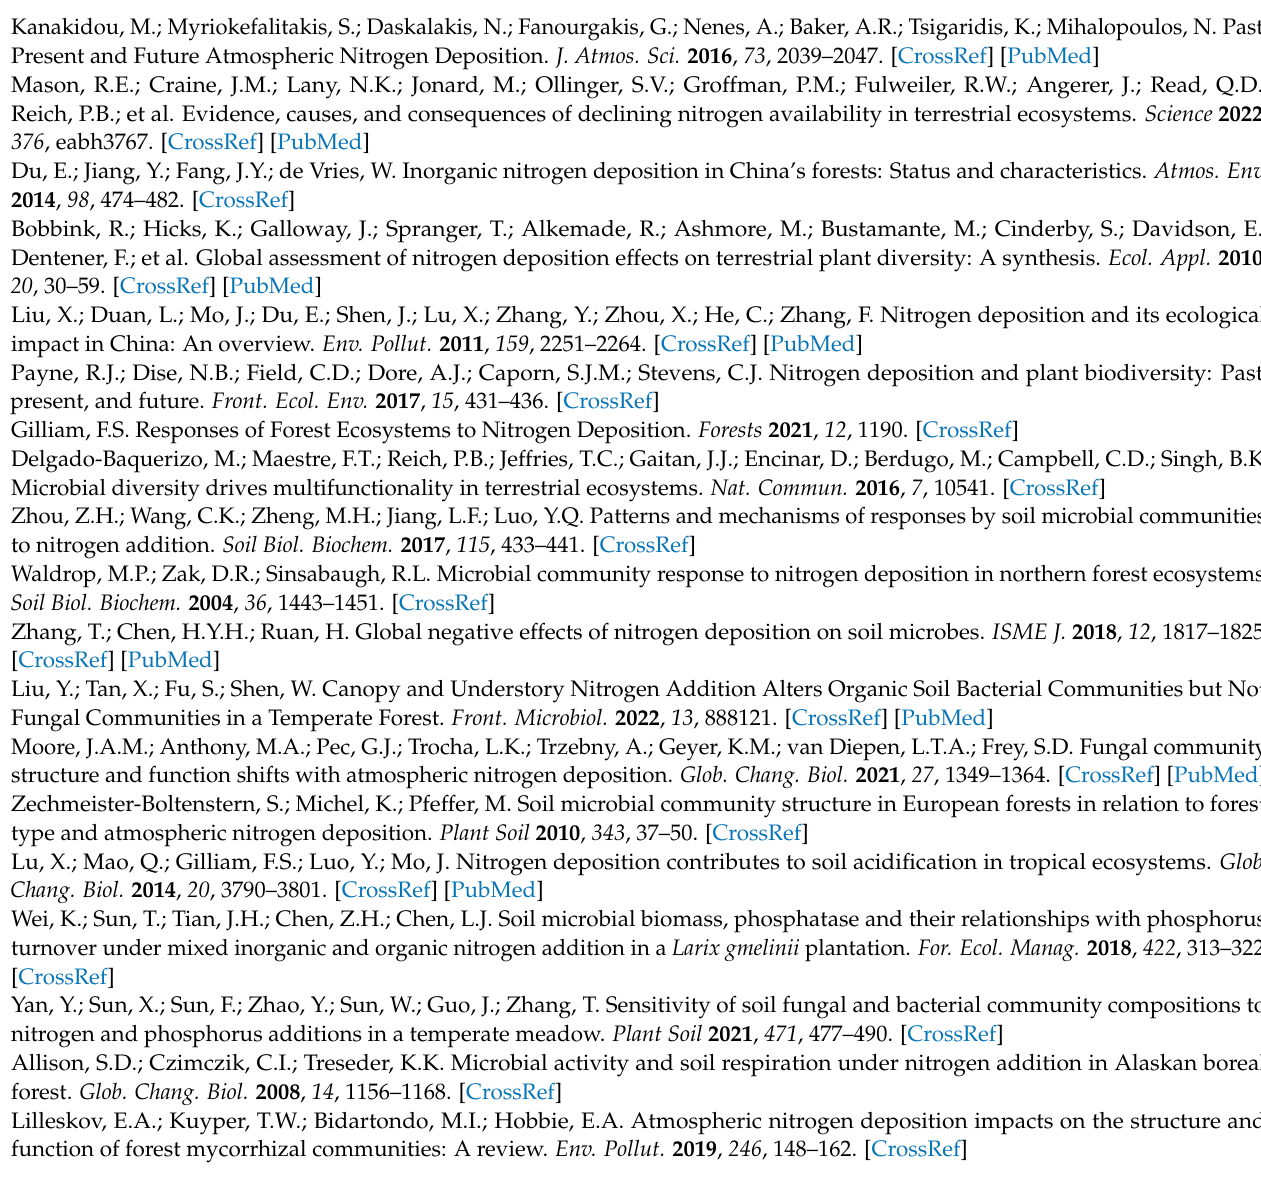
Figure A2. Pearson correlation between alpha diversity and environmental factors. Blue indications a negative correlation, and red a positive correlation, and the strength of color reflects the strength of the correlation. Abbreviations: NO 3 − , nitrate nitrogen; NH 4+ , ammonium nitrogen; STN, total nitrogen; SOC, soil organic carbon; STP, total phosphorus; SWC, soil water content. * p <